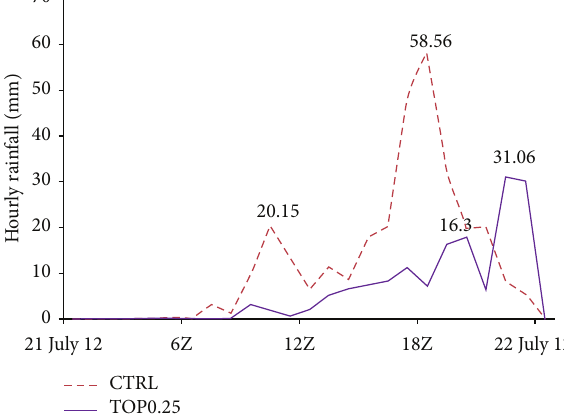
Figure 11: Time series of 1h rainfall from CTRL (dash) and TOP0.25 (solid) at Fangshan (115.98 ∘ E, 39.72 ∘